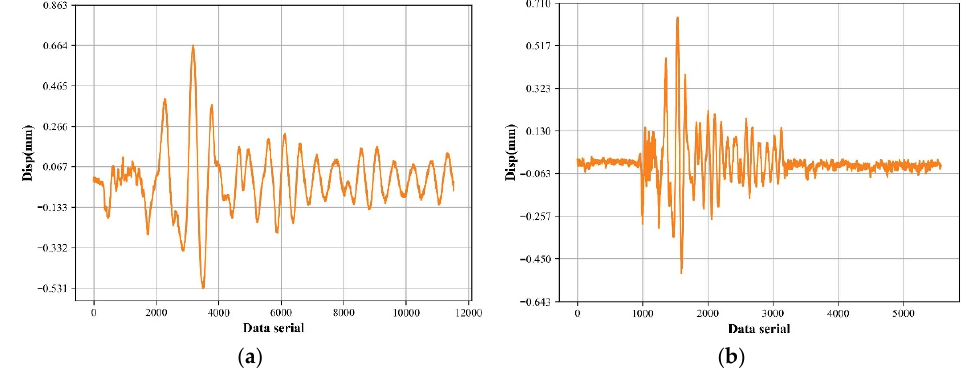
Figure 13. The original displacement sequence; where ( a ) is the input displacement sequence used to control the vibration of the shaking table, ( b ) is the displacement sequence calculated by the improved phase correlation method in this paper.